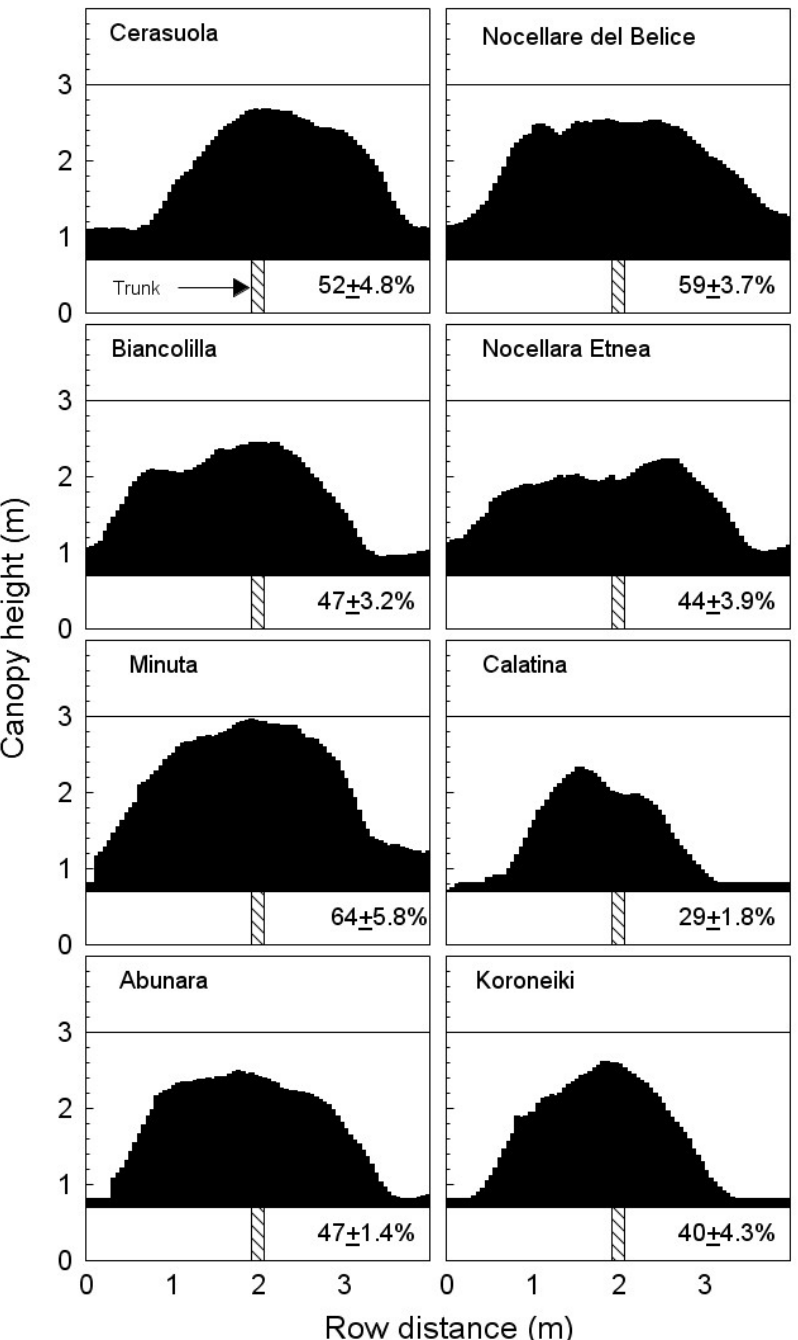
Figure 5. Canopy height profile of olive trees of different cultivars planted at 4 × 4 m. The average canopy height profile of 10 trees is reported for each cultivar. In each section, the percentage of the canopy wall filled by the canopy is also reported. The canopy wall (4 × 2.3 m) was calculated considering the distance between trees along the row (4 m), a trunk height of 0.7 m and a canopy height considered optimal for the agronomic management (3 m).